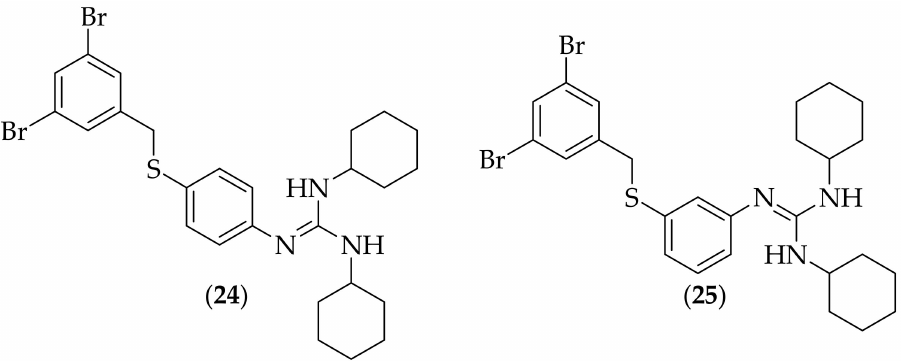
Figure 14. Fungicidal benzylsulfanyl-phenylguanidines ( 24 ) and ( 25